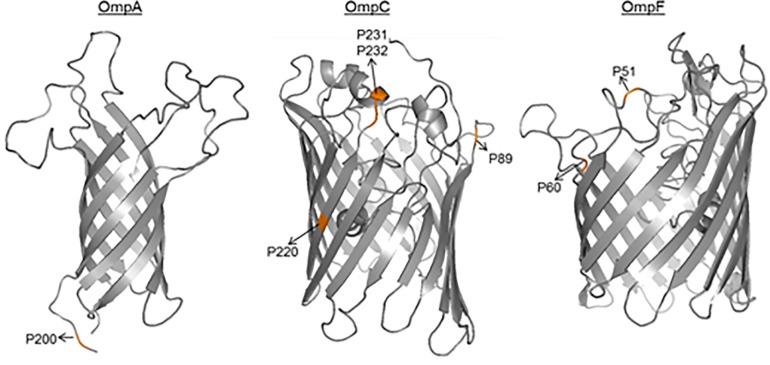
3D- monomer representations of the transmembrane domains of OMPs. The amino acid positions related to pathotype and/or adhesion and invasion indices are highlighted.